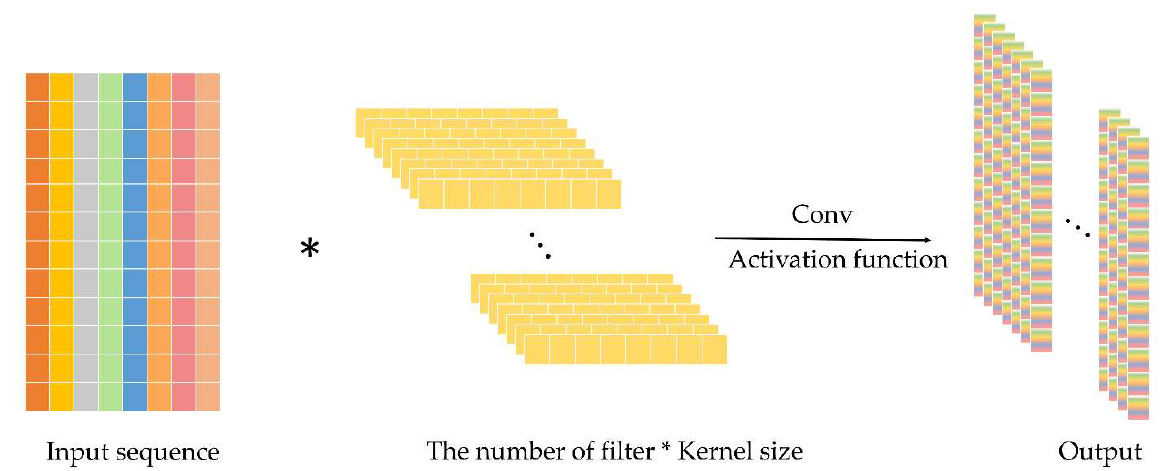
Figure 4. Schematic diagram of the convolution process.